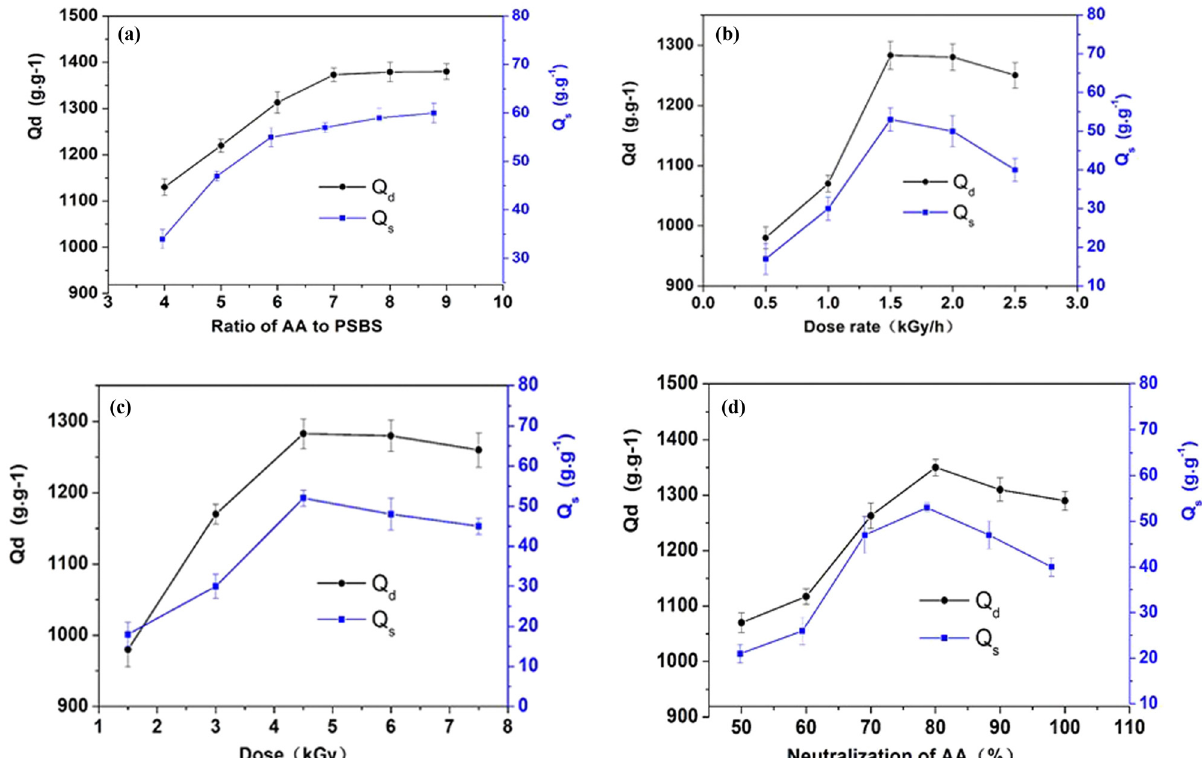
Figure 3: Single - factor experiment for water absorption. ( a ) Rate of AA to PSBS, ( b ) irradiation dose rate, ( c ) irradiation dose, and ( d ) neutralization of